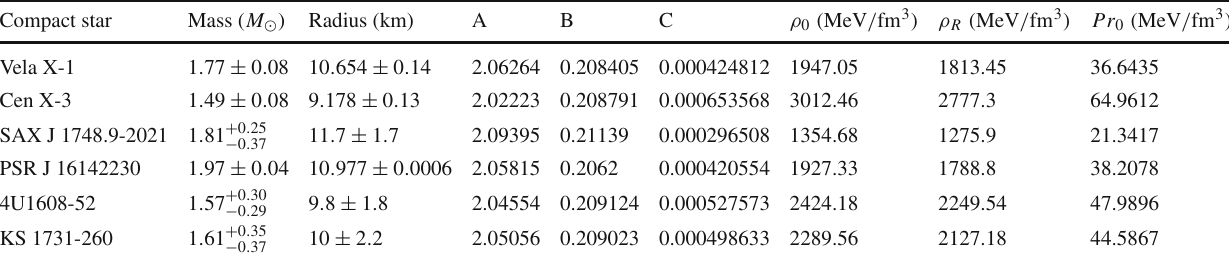
Table 4 Best fitted values of model parameters for different known compact objects for α = 25 in 5D Compact